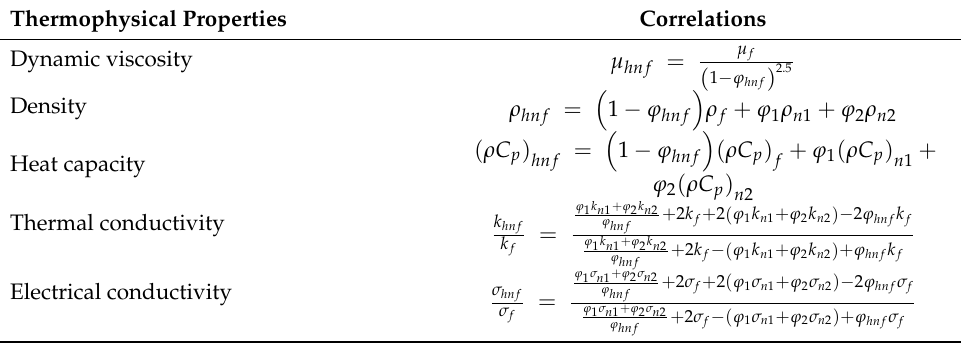
Table 2. Thermophysical properties of nanofluid and hybrid nanofluid. Thermophysical